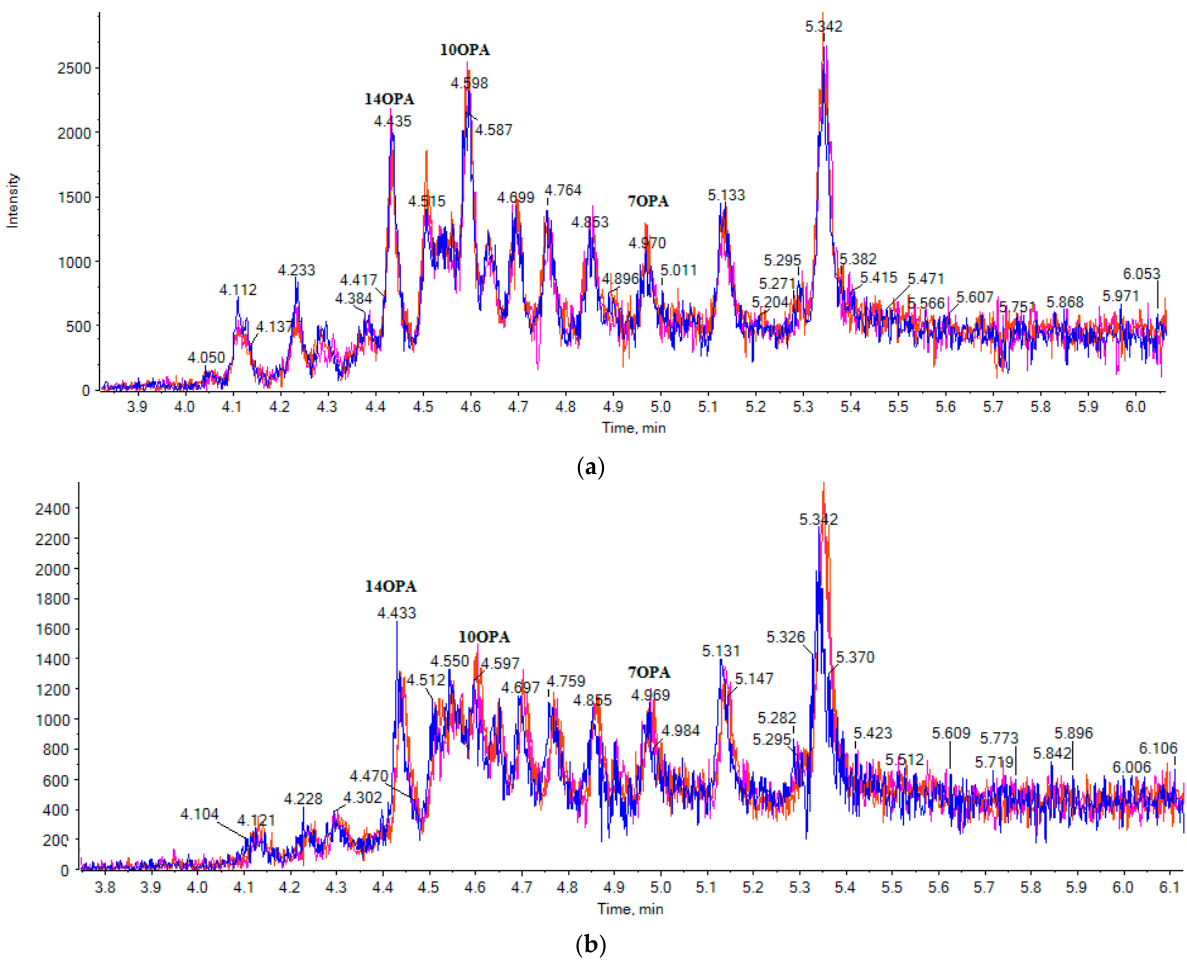
Figure 3. EICs of the multisample analysis for OPAs (exact mass m/z 269.2122) in three cow milk samples ( a ) and in three goat milk samples ( b ).